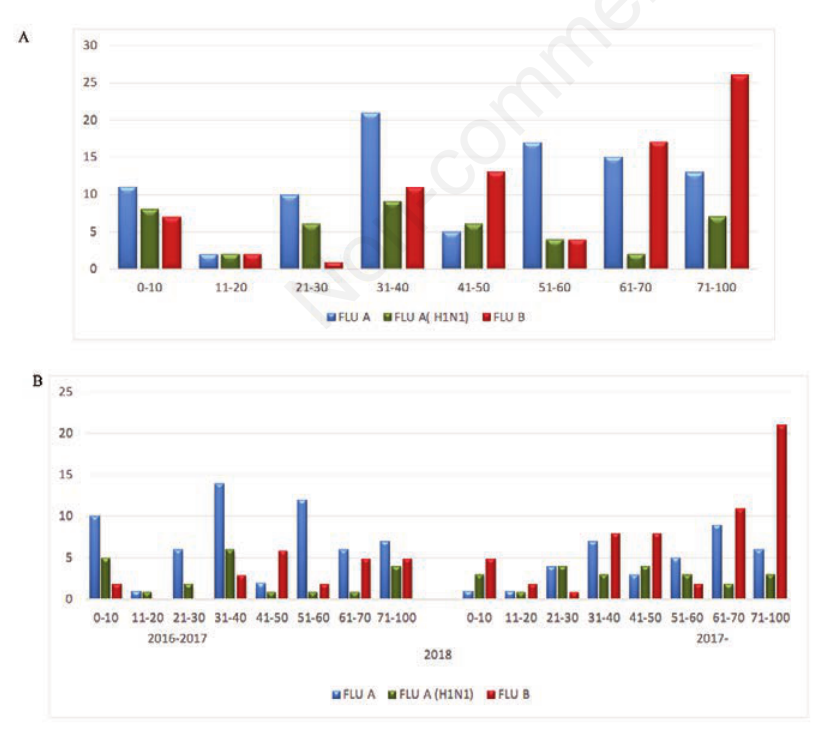
Figure 2. Frequency of patients with Flu A, Flu A (H1N1) and Flu B according to differ- ent age groups. A: results referring to the whole study duration (2016-2018); B: break down of the results according to the 2016-2017 and 2017-2018